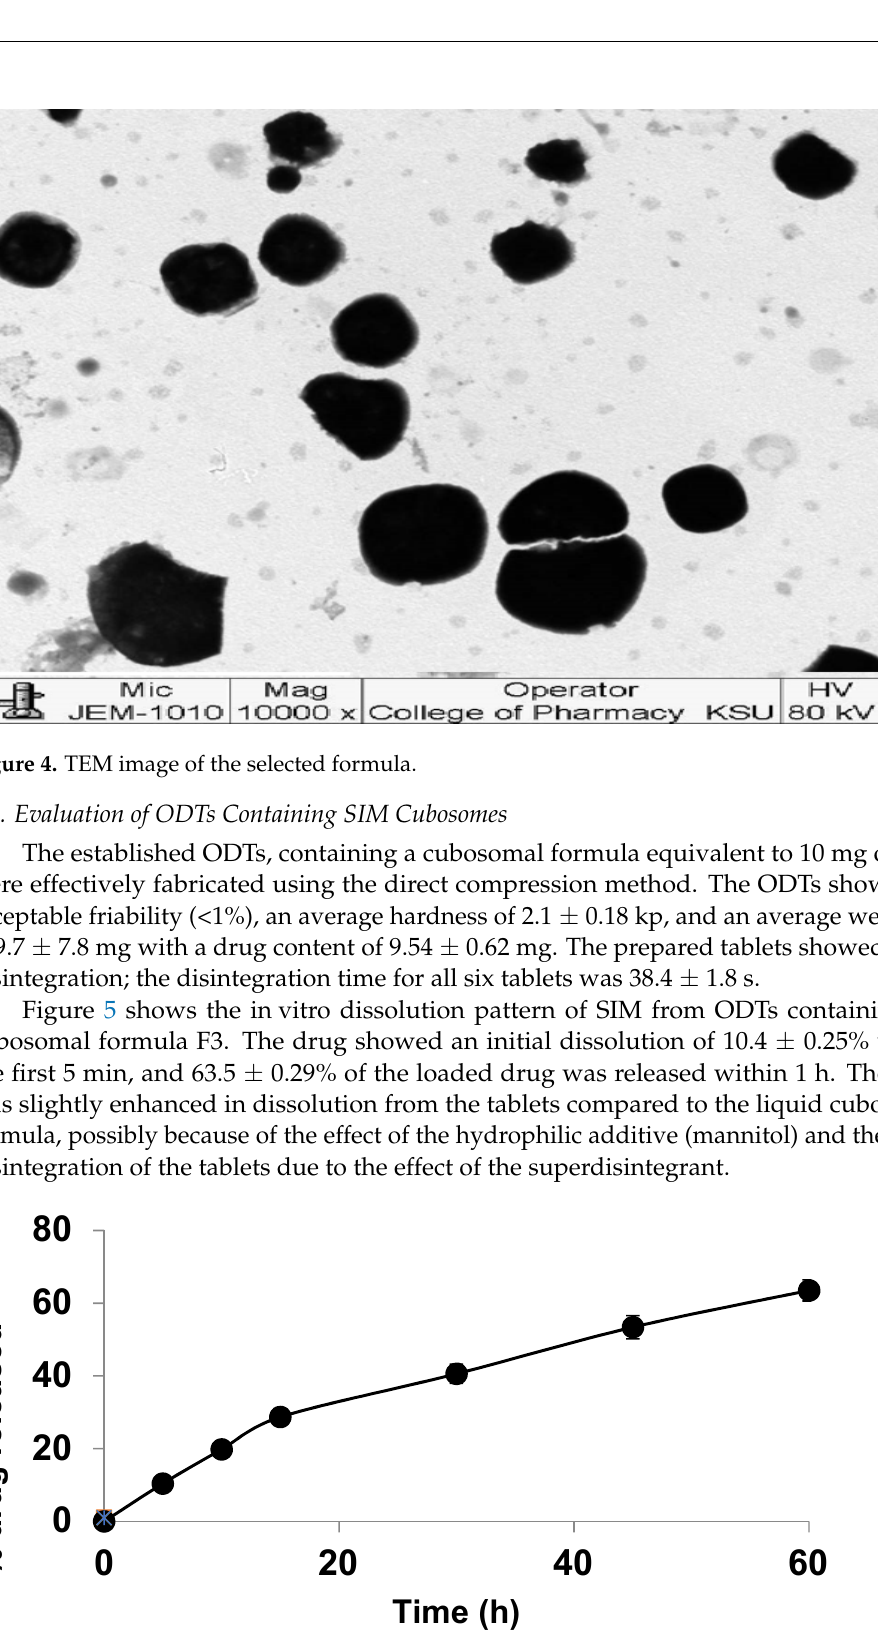
Figure 5. In vitro dissolution of SIM from ODTs containing drug-loaded cubosomal formula F3.